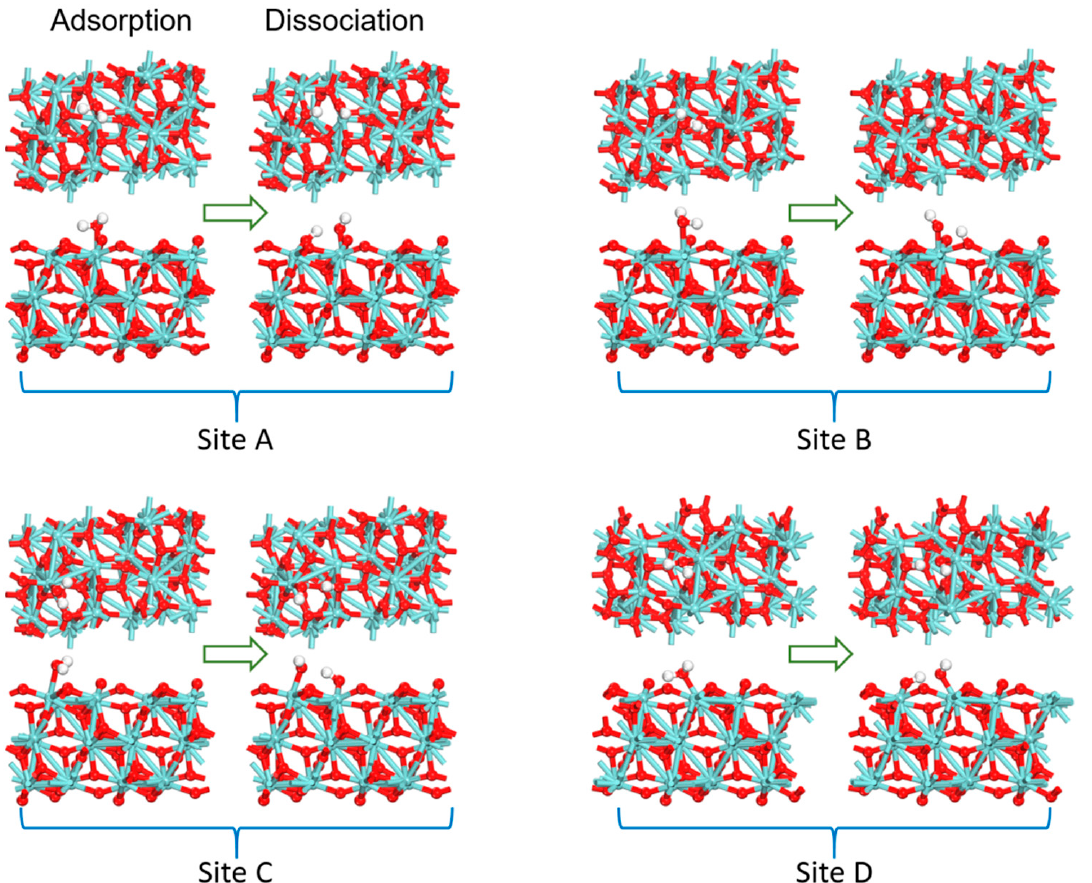
Figure 3. Stable adsorption structures of a water molecule at A , B , C and D sites on the monoclinic ZrO 2 (111) surface and the corresponding dissociation structures.